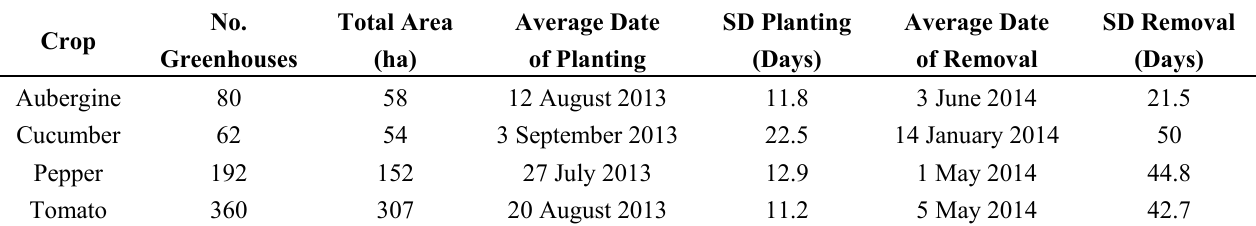
Table 1. Characteristics of the 694 reference greenhouses. SD: Standard deviation.